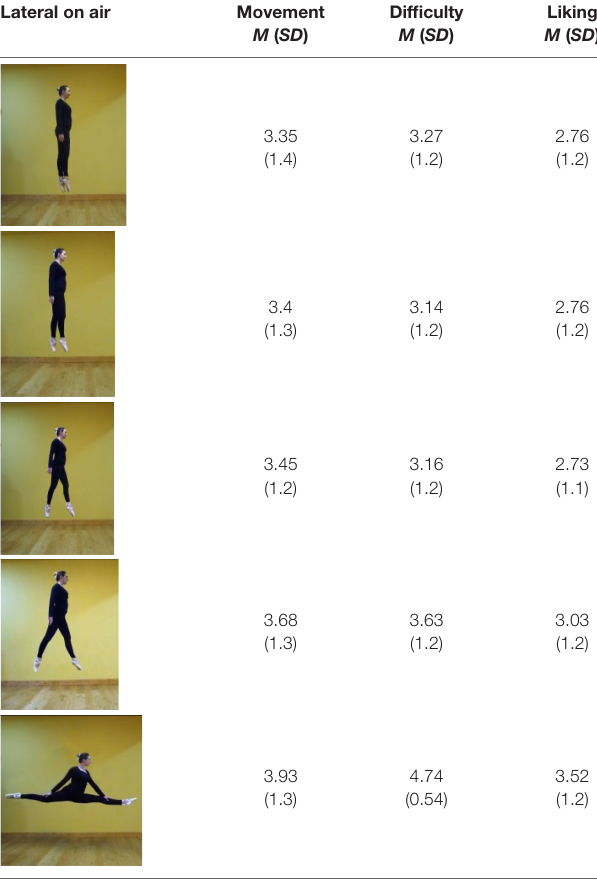
TABLE 2 | Lateral in-air poses: mean ratings (and SD) for movement, difficulty, and liking. Lateral on air